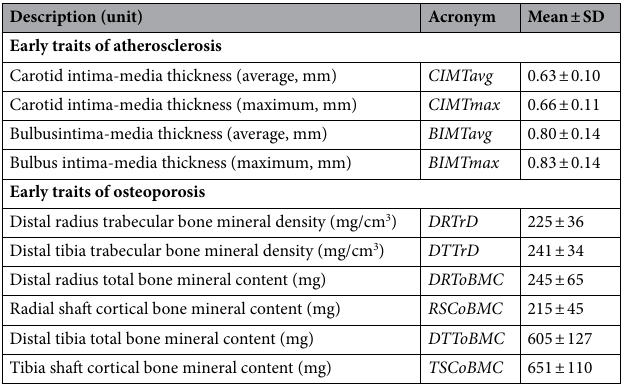
Table 2. Early traits of osteoporosis and atherosclerosis with their descriptive statistics among the study participants, expressed as mean ± SD.